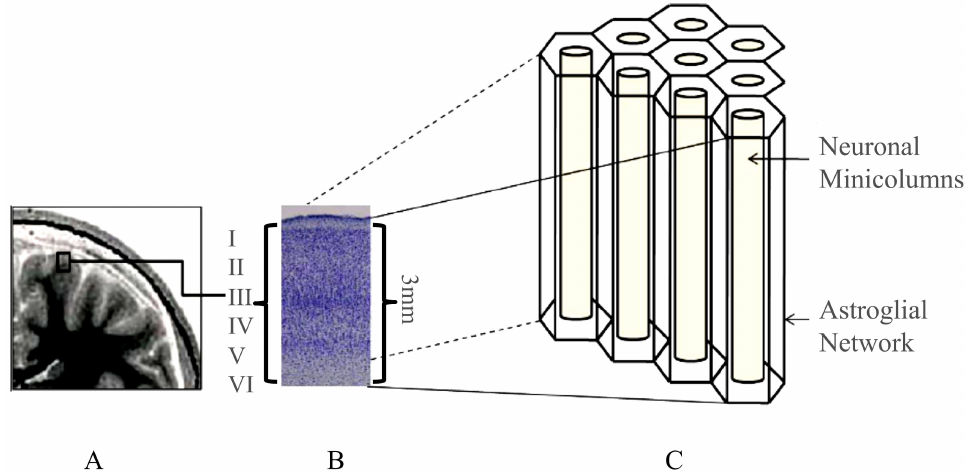
Figure 1. Three-dimensional (3D) organization of the human neocortex. Scanning imaging of the human brain ( A ). Histological section of the human cerebral cortex organized in layers ( B ). Astroglial matrix (hexagonal network) surrounding neuronal minicolumns and layers ( C